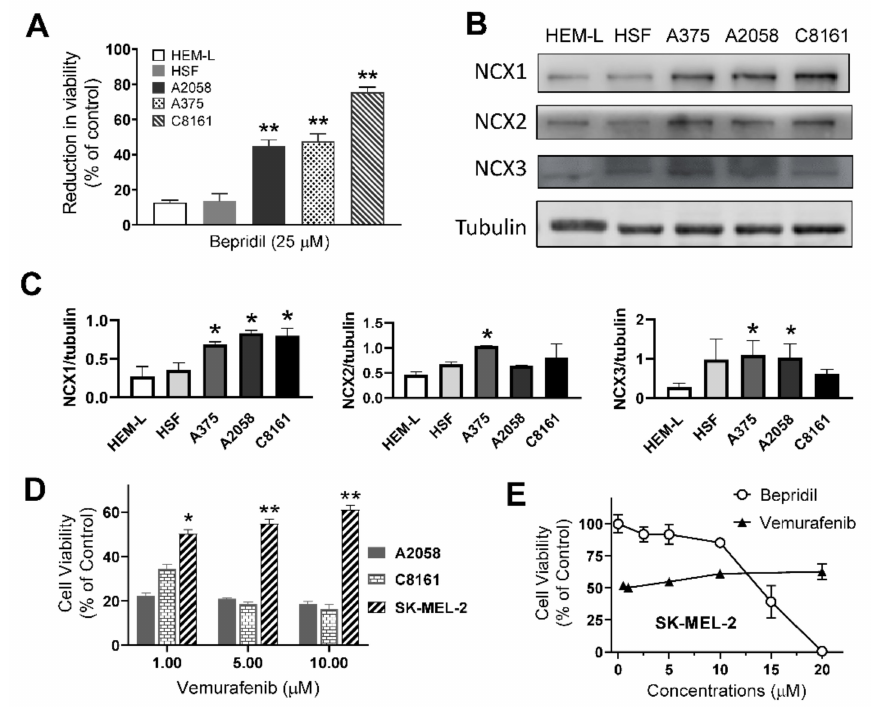
Figure 6. The impact of bepridil on melanocytes and NRAS mutated melanoma cell. ( A ) Human melanoma cells, epidermal melanocytes-light (HEM-L) cells, and skin fibroblasts (HSF) were treated with bepridil (25 µ M) for 24 h. Reduction in cell viability was expressed as the percent reduction with respect to control cells. ** p < 0.01, each cell line compared with HEM-L, n = 3. ( B ) The three NCX isoforms detected in these cell lines. ( C ) Quantifications of the three NCX isoforms obtained by western blotting. * p < 0.05, each cell line compared with HEM-L, n = 3. ( D ) Effects of the BRAF inhibitor vemurafenib on viability of A2058, C8161 and SK-MEL-2 cells, 72 h. * p < 0.05, ** p < 0.01, SK-ME-2 compared with C8161 or A2058 cell line; one-way ANOVA followed by a Tukey’s post- hoc test, n = 5. ( E ) The dose–response relation between pharmacological agents and viability of SK-MEL-2